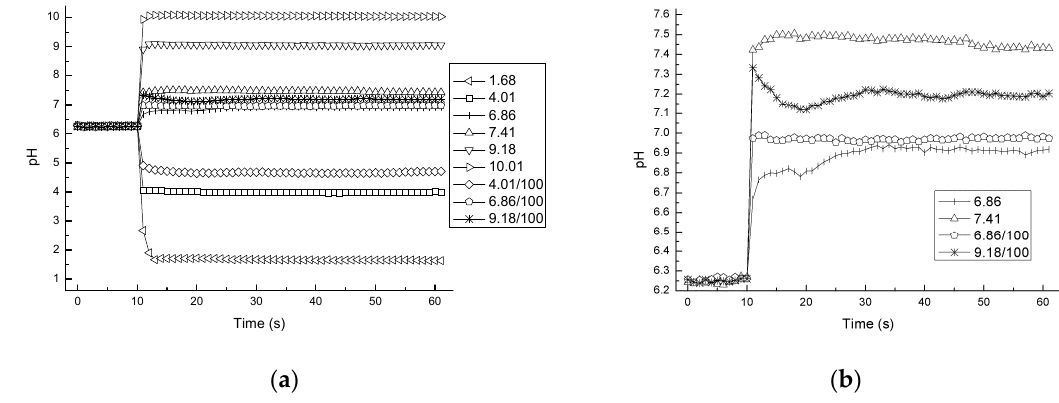
Figure 7. ( a ) Response curves of nine sample solutions measured by the present system; ( b ) Expansion of the Y-axis of four sample solutions of ( a ). The data are plotted from 10 s before the solutions were switched.